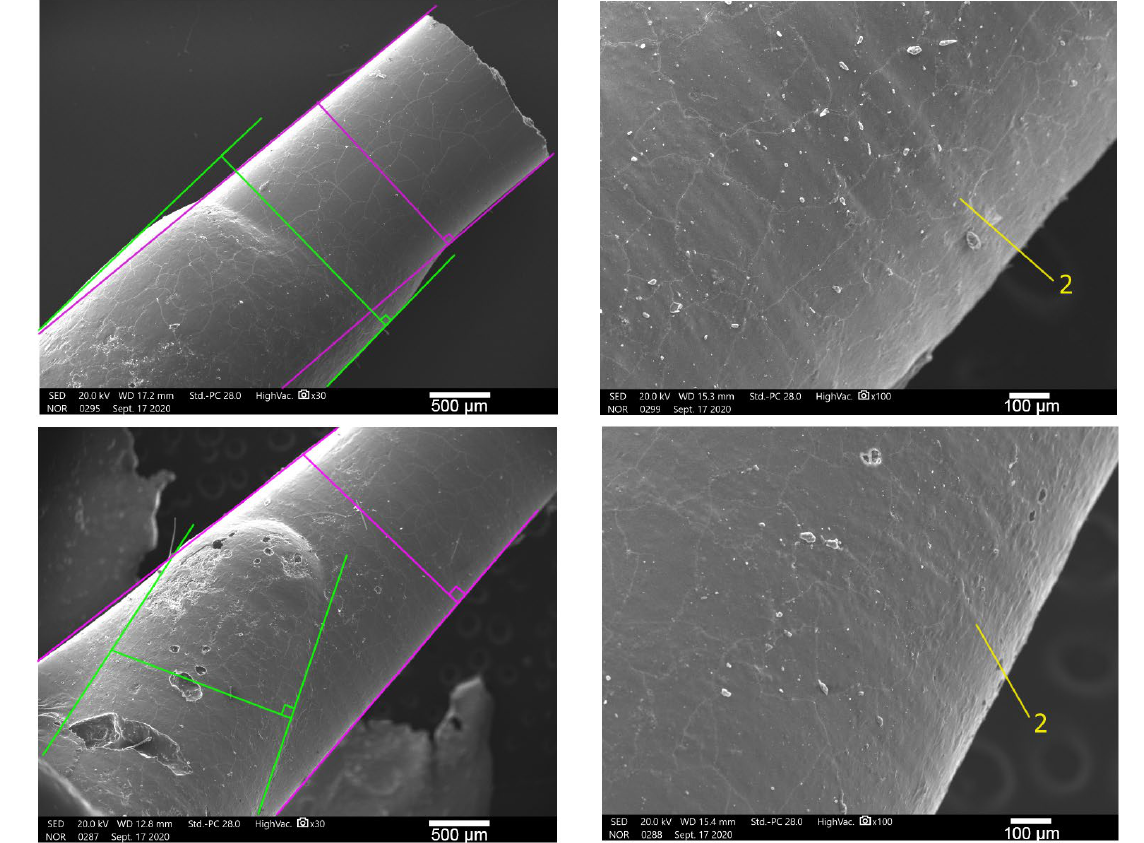
Figure 13: SEM images of the perforation casts of Hope Estate rock crystal beads SM-02-77 (top) and SM-02-80 (bottom). The perforation of SM-02-077 is highly polished where its diameter is smallest. The perforation of SM-02-080 clearly shows an error in the angle at the beginning of the perforation, which was later corrected by the craftsman. Although the surface of the perforations is very smooth, the striations are still visible